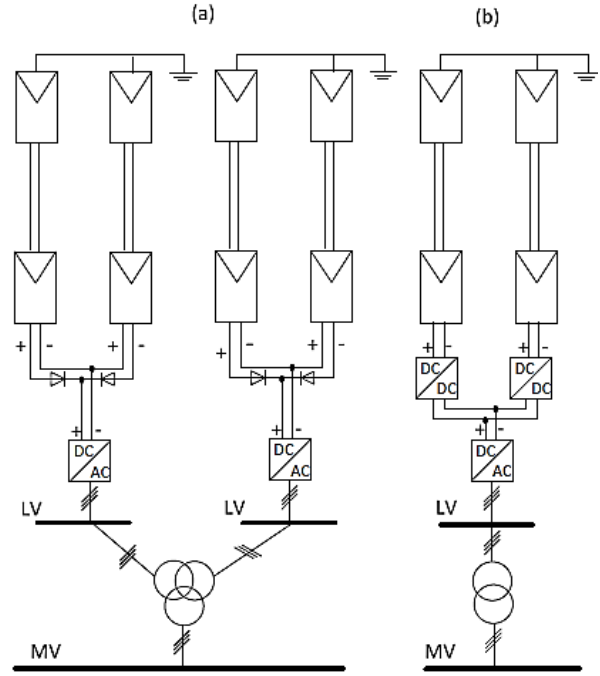
Figure 3. PV inverter topologies: ( a ) Central PV inverter; ( b ) Multistring PV inverter.